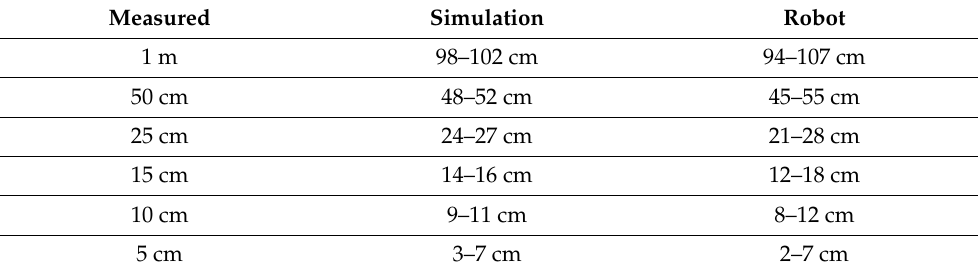
Table 3. Advancing